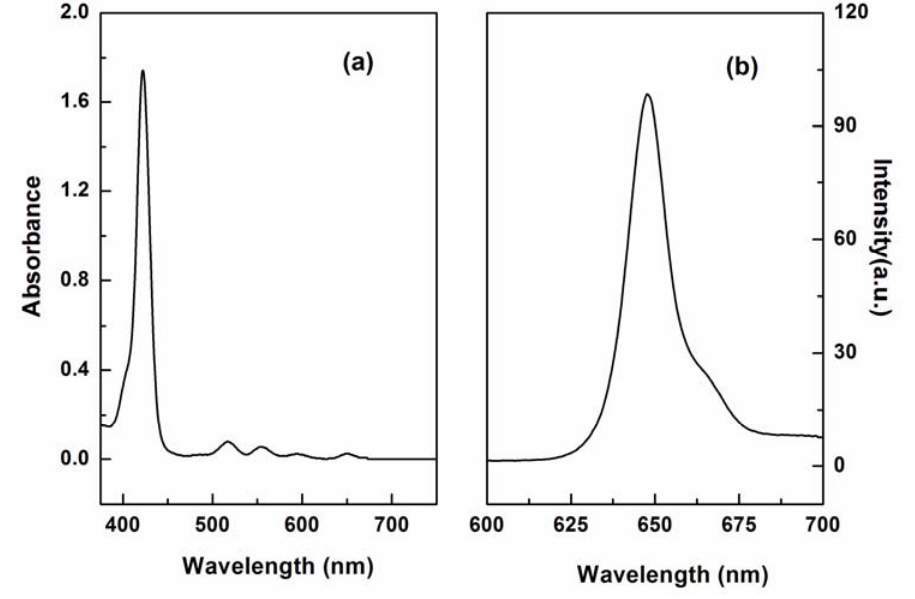
Figure 1. Absorption ( a ) and ( b ) fluorescence emission spectra of the P1 solution (10 μ